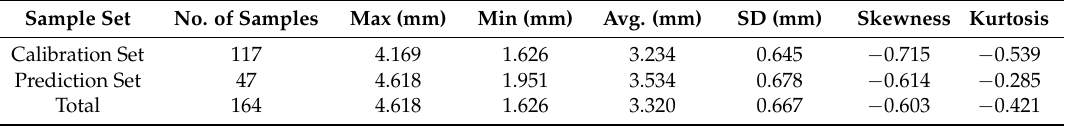
Table 1. Summary statistics on tracheid length of larch in each data set.